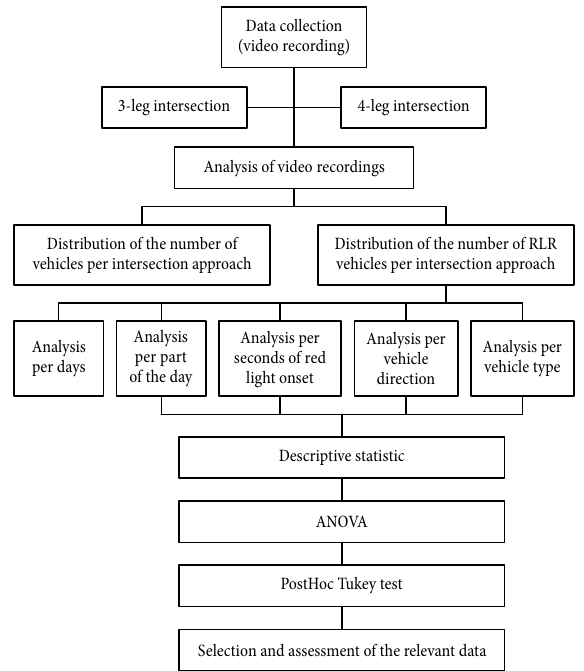
Fig. 1. Algorithm of researched method